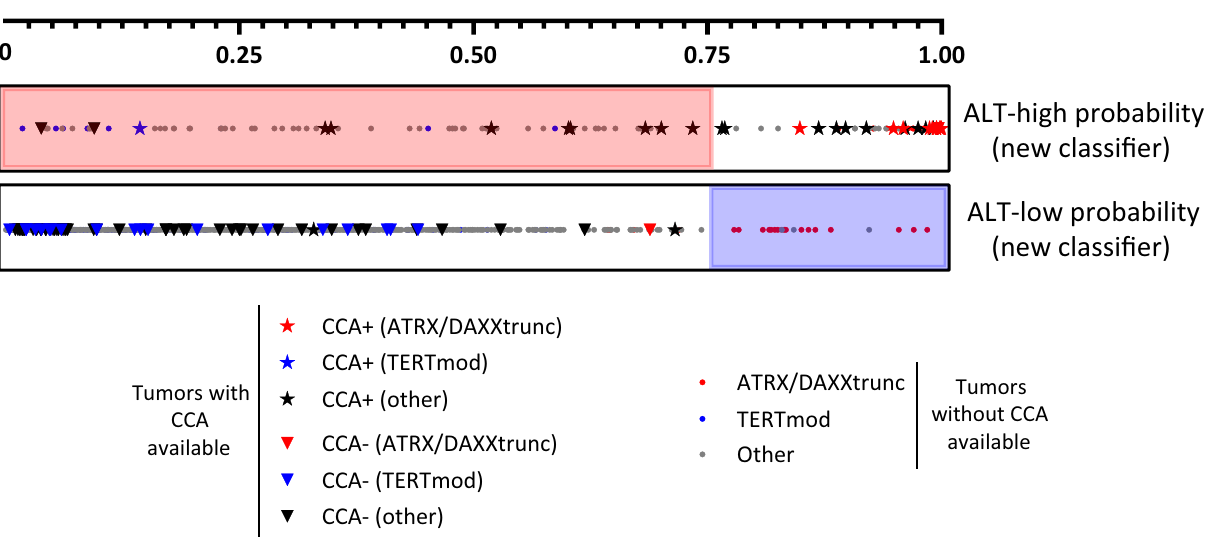
Fig. 1 Comparison of the ALT-probability score of Sieverling et al. 2 , with the new classi fi er proposed in this article. The 2497 patients described in Sieverling et al. are divided here into two groups: ALT-high probability (upper bar) and ALT-low probability (lower bar) according to the new classi fi er. Within the two bars, each patient is represented by a symbol placed on a scale from 0 to 1 according to its Sieverling ALT-probability score. Star and inverted triangle symbols represent patients whose tumors were C-circle assay (CCA) positive or negative, respectively 3 , and the dots represent patients for whom CCA data are unavailable. Red and blue symbols correspond to patients with ATRX/DAXXtrunc and TERTmod alterations, respectively 2 . The pink and blue shading highlights the tumors for which the two scores were discordant: the pink shading in the upper box indicates tumors with ALT-high probability (new classi fi er), that were ALT-probability <0.75 (ALT-low) by Sieverling ’ s score; the blue shading in the lower box indicates tumors with ALT- low probability (new classi fi er), that were ALT-probability >0.75 (ALT-high) by Sieverling ’ s score.